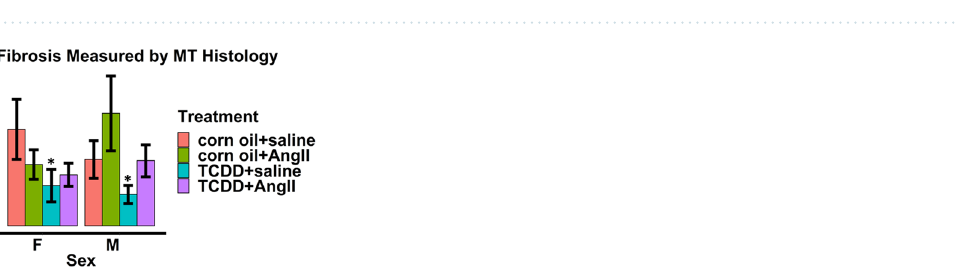
Figure 6. Echocardiography measurements of cardiac structure for mice with osmotic pump implants. Absolute end diastolic volume ( A ), left ventricle mass/BW ( B ), stroke volume ( C ), and ejection fraction ( D ). Values are mean + SE. * p < 0.05 using Welch two-sided t-test comparing saline to Ang II by each sex and either corn oil or TCDD. # p < 0.05 using Welch two-sided t-test comparing TCDD to corn oil by each sex and either saline or Ang II. Corn oil + Ang II: n = 6 females, 7 males; Corn oil + saline: n = 4 females, 5 males; TCDD + Ang II: n = 7 females, 7 males; TCDD + saline: n = 6 females, 9 males. BW body weight, EDV end diastolic volume, LV left ventricle.